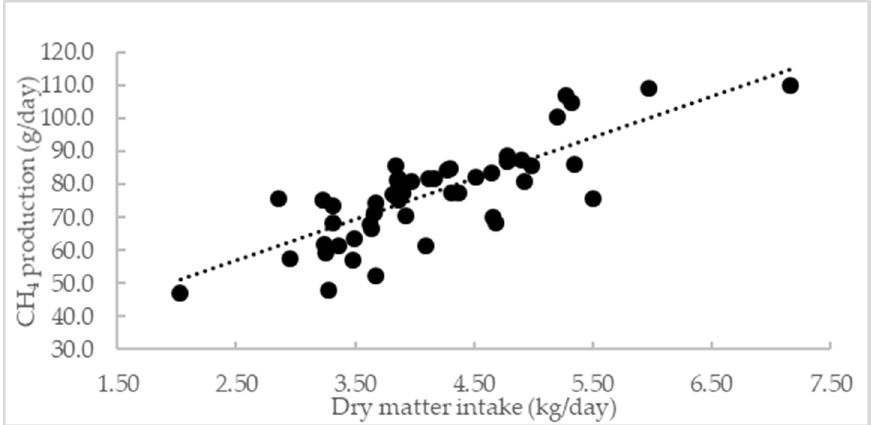
Figure 2. The relationship between dry matter intake (kg / day) and CH 4 production (g / day). The relationship can be described as CH 4 production (g / day) = 26.11 + 12.39X, where X = dry matter intake (kg / day) R 2 = 0.74, p < 0.0001. Table 4. Relationship between the products of rumen fermentation and the percentage of Desmanthus (on dry matter basis) in the diet.